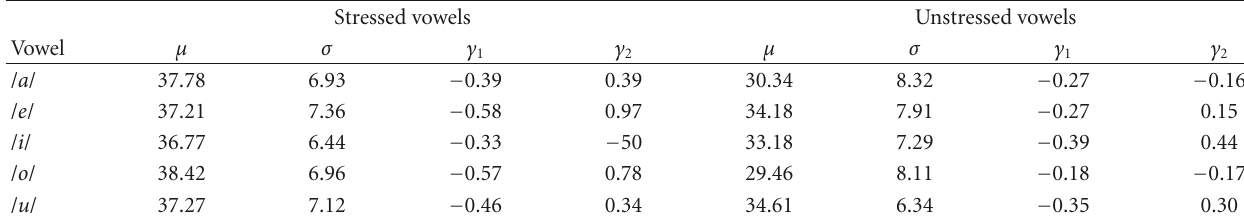
Table 7: Mean ( μ ), standard desviation ( σ ), skewness ( γ excess Kurtosis ( γ